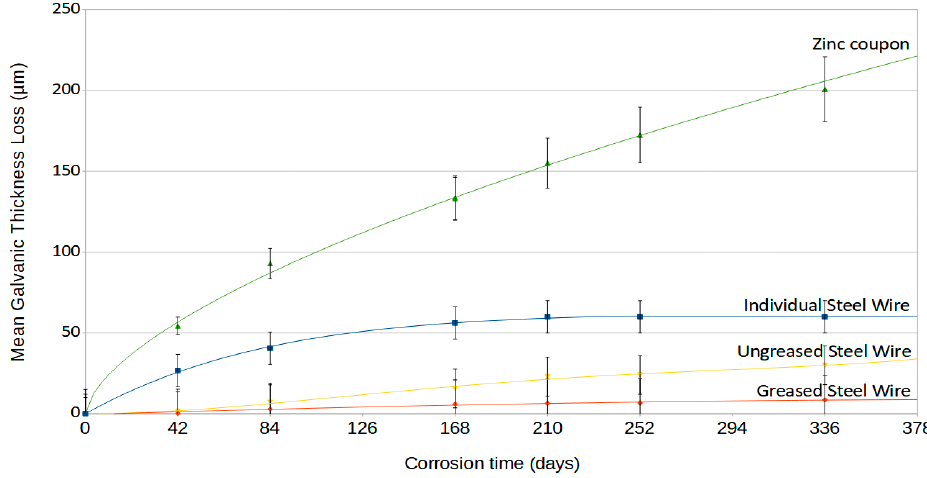
Figure 10. Mean zinc thickness loss on galvanized steel wires.